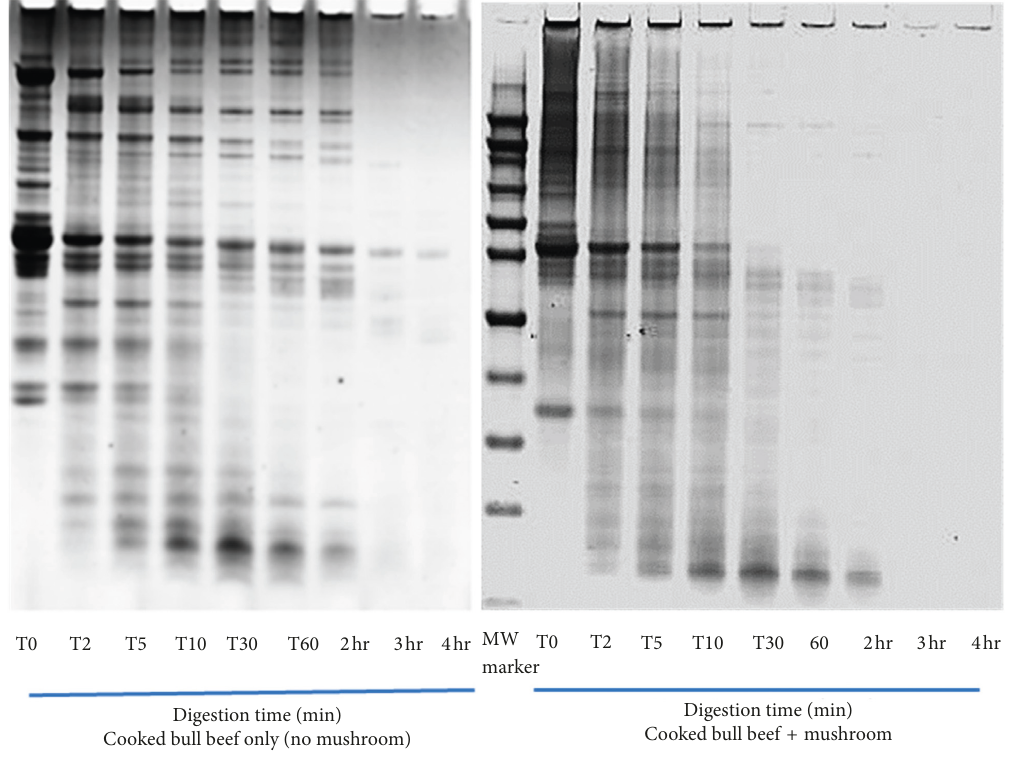
Figure 8: Experiment 5: SDS PAGE showing the effect of vegetable accompaniments in a cooked “meal” containing semimembranosus from cow, bull, or calf on the digestibility of total proteins. Results of gastric and intestinal phases for the meal containing pooled bull meat from Experiment 1 with and without mushroom are presented as